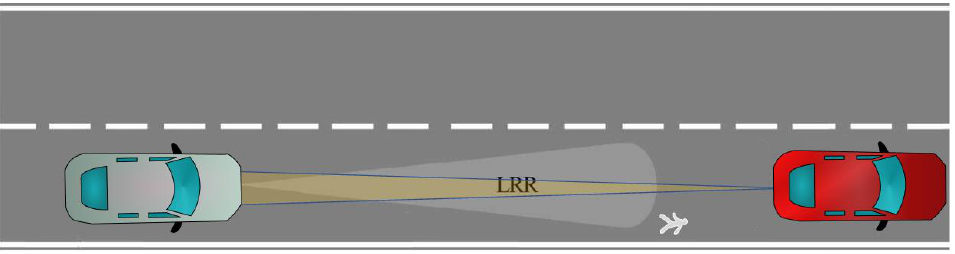
Figure 3. Scenario-3. An RVGPO/I technique for spoofing the real pedestrian echo. Scenario-4